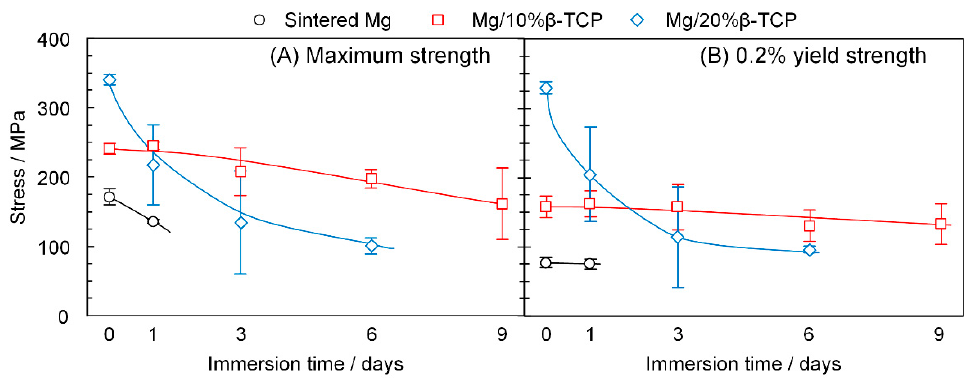
Figure 9. ( A ) Maximum strength and ( B ) 0.2% yield strength before and after immersion for each prescribed period.